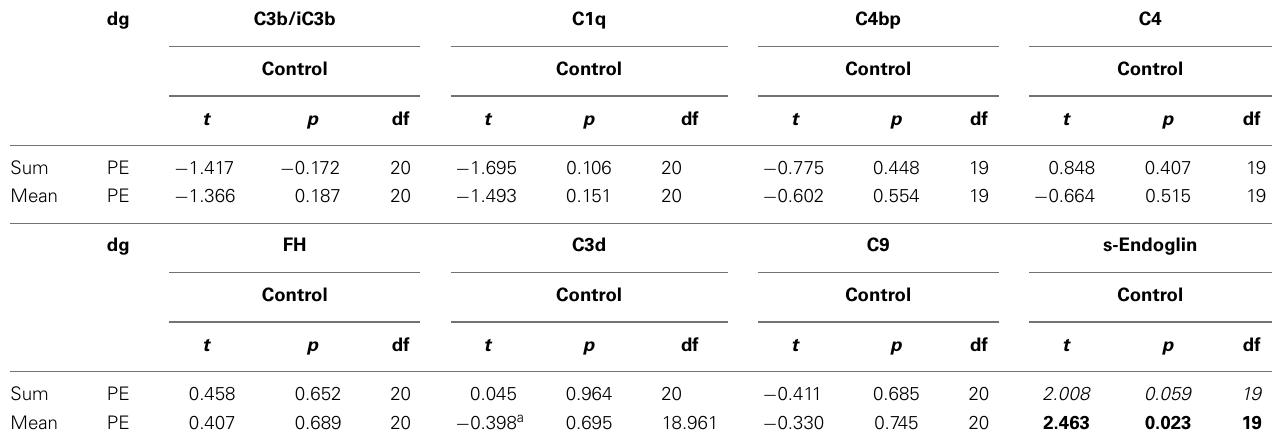
Table 6 | Complement and s-endoglin deposition in preeclampsia (PE) vs. control .